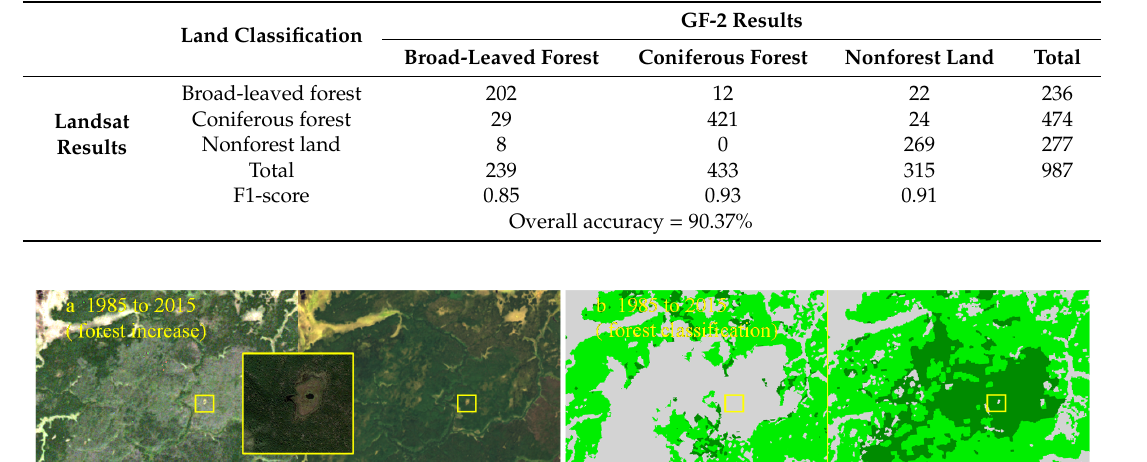
Table 2. Accuracy assessment using Gaofen-2 (GF-2) images.